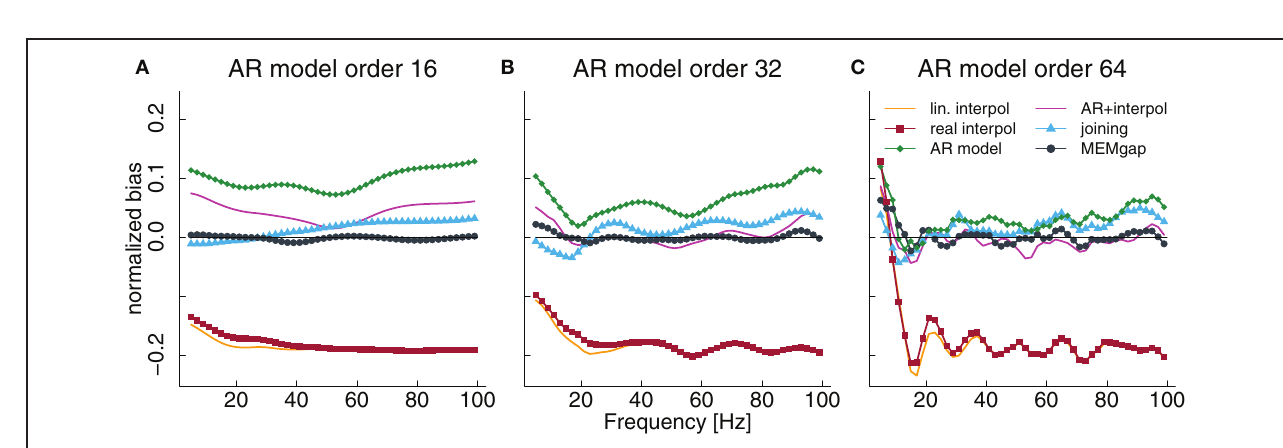
normalized RMSE in (A–C) , the normalized estimation bias in (D–F) , and the normalized variance in (G–I) relative to the gap size for the different algorithms. The thin black line in (D–F) denotes an ideal estimation bias of 0.